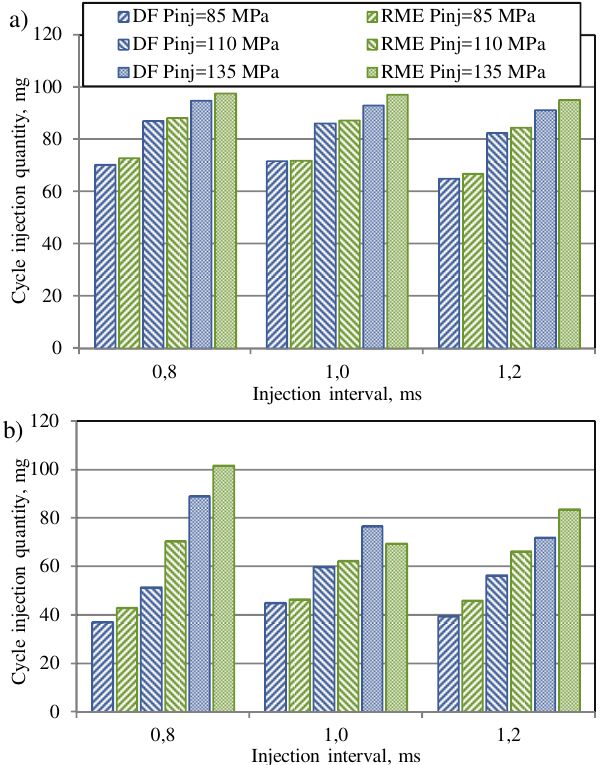
Fig. 5. The effect of injection interval on cycle injection quantity for various injection pressures: a – injector energizing pulses of 0.15–1.0 ms; b – injector energizing pulses 0.5–0.5